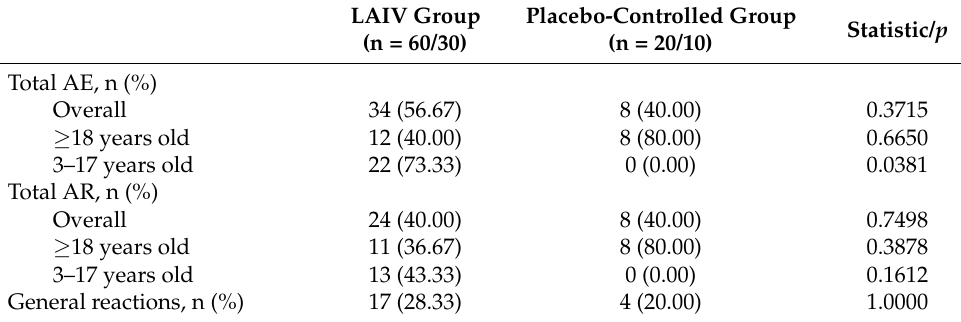
Table 2. Adverse events and details of adverse reactions